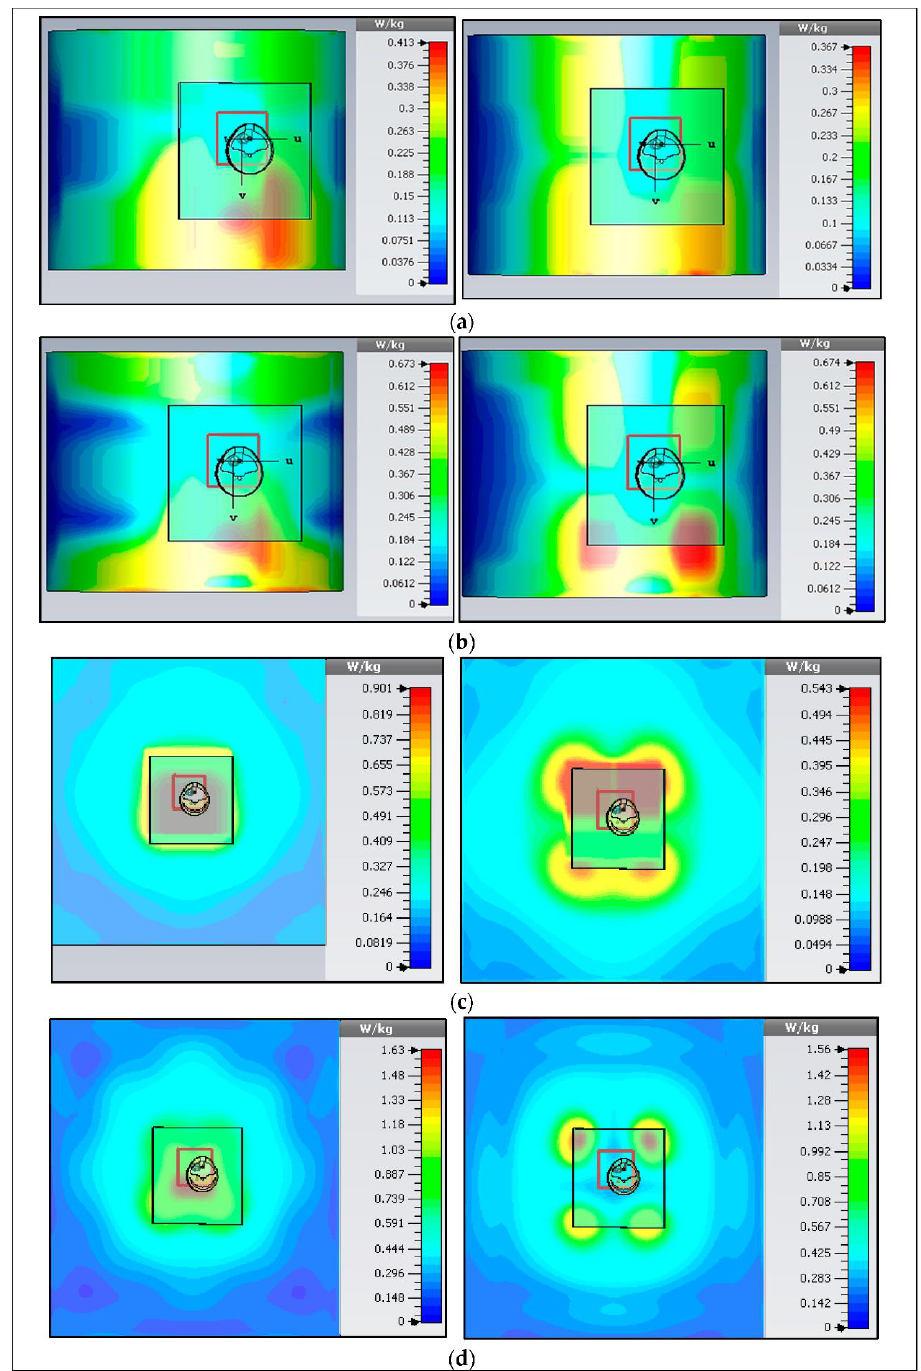
Figure 28. Simulated SAR (10 g, and 1 g) in the lower (upper) bands. ( a , b ) on-arm (at 2.38 GHz and 5.4 GHz), and ( c ,d) on-chest (at 2.38 GHz and 5.46 GHz)). Table 3. Different SAR Values in Flat Positions.